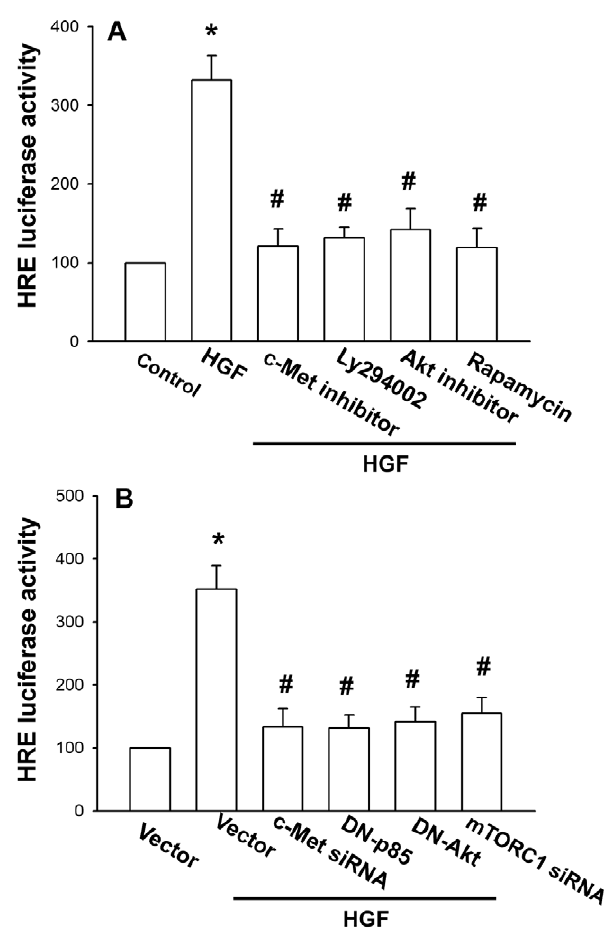
Figure 6. The c-Met/PI3K/Akt/mTORC1 signaling pathway is involved in the increase of HIF-1 a activity in response to HGF. OASFs were pretreated with c-Met inhibitor, Ly294002, Akt inhibitor, and rapamycin for 30 min (A) or co-transfected with c-Met and mTORC1 siRNA or p85 and Akt mutant (B) before exposure to HGF. HRE luciferase activity was measured 24 h after HGF treatment, and the results were normalized to the b -galactosidase activity and expressed as the mean 6 S.E. for three independent experiments performed in triplicate. Results are expressed as the mean 6 S.E. *, p , 0.05 compared with control; # , p , 0.05 compared with HGF-treated